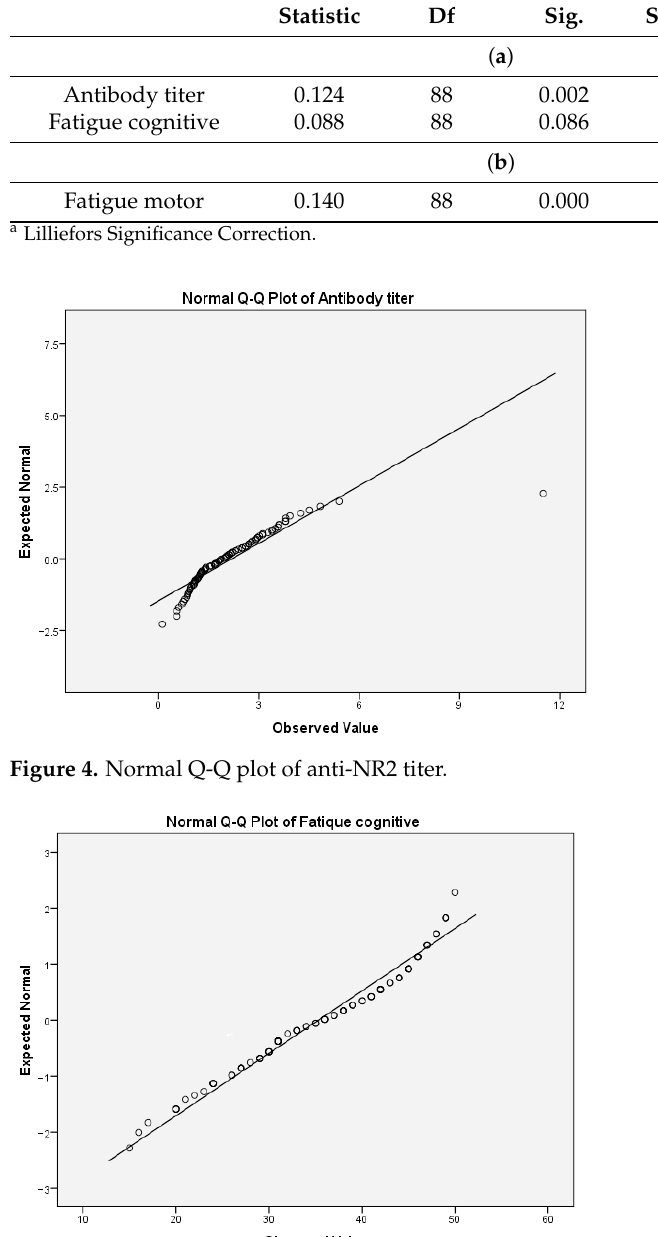
Table 9. ( a ) Tests of normality for cognitive fatigue . ( b ). Tests of normality for motor fatigue .